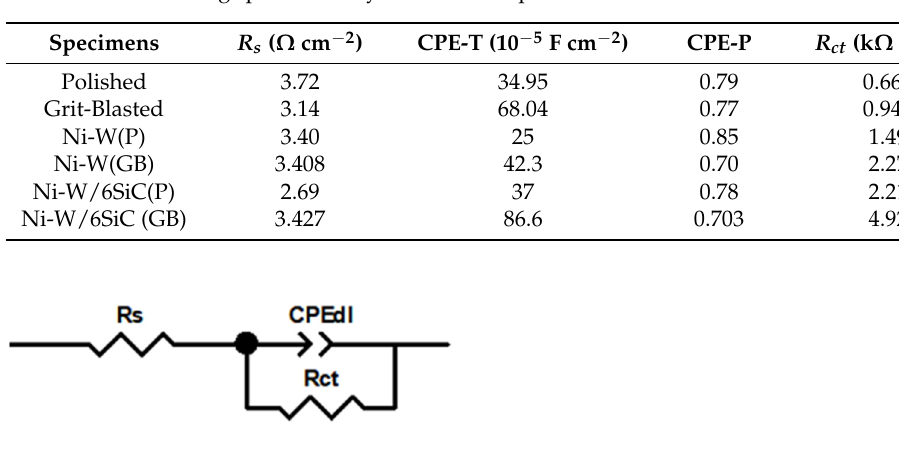
Figure 17. Electrochemical impedance spectra for the Ni-W and Ni-W/SiC coatings on 45 steel substrates subjected to two different pretreatments in 3.5 NaCl: ( a ) Nyquist plots; ( b ) Bode plots. Table 6. The equivalent circuit parameters and fitting results of the impedance spectra of the Ni-W and Ni-W/SiC coatings pretreated by two different processes.